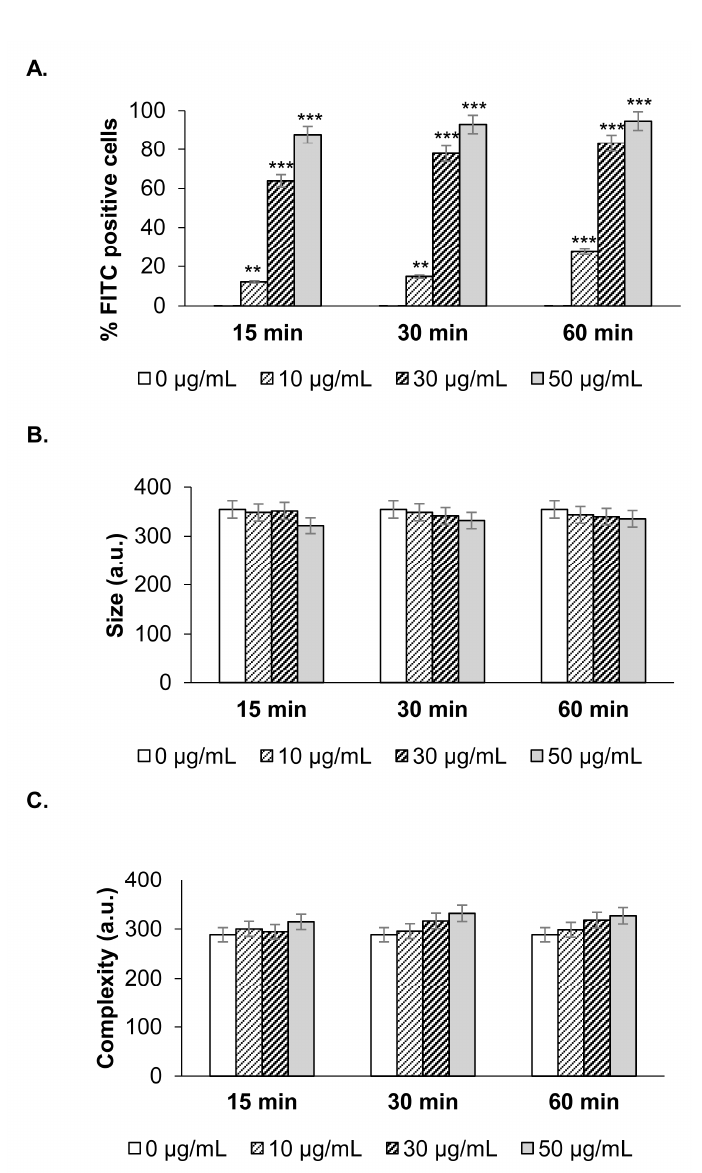
Figure 5. Incorporation of FITC-NanoMBGs by Th2 CD4 + SR.D10 cell line. Analysis of nanomaterial incorporation in SR.D10 cells which were incubated with a range of FITC-NanoMBG concentrations, during the time indicated in the figure. ( A ) Frequency of FITC positive cells. ( B ) Analysis of size and ( C ) complexity of the cellular population. Data (mean ± SEM) from one representative experiment out of three, each with triplicates, are shown. Asterisks indicate significant difference when cells in the presence or absence of NanoMBGs are compared. ** p < 0.01; *** p < 0.001.